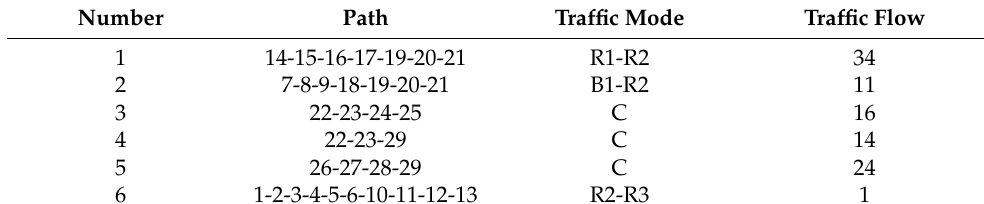
Table 5. The traffic flow assignment and composition of transportation mode for the shortest path.